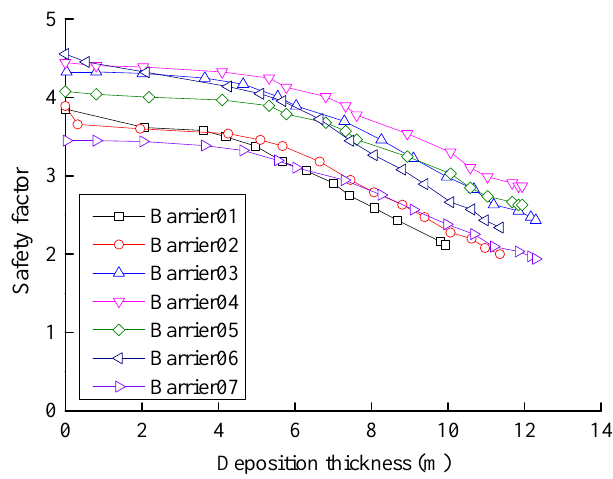
Figure 11. Variation of the safety factor of the barrier with deposition thickness at the front of the